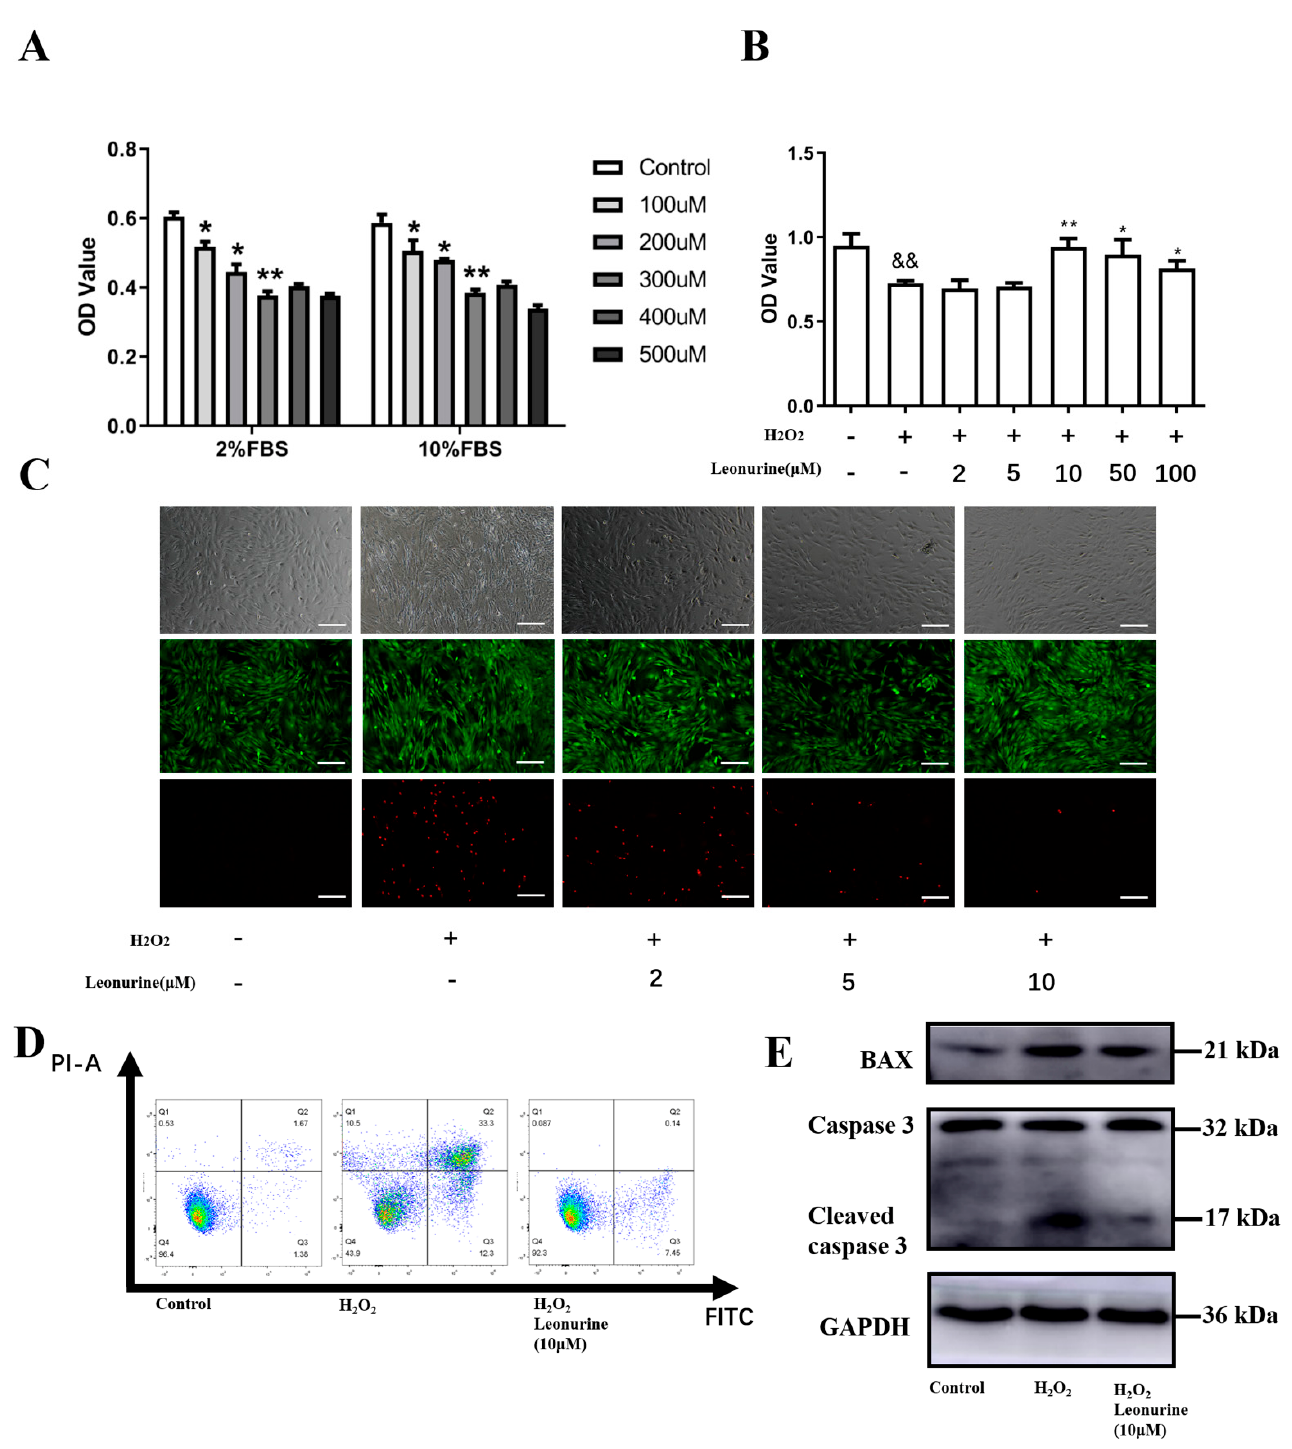
Figure 1. ( A ) CCK-8 essay for BMSCs co-cultured with different concentrations of H 2 O 2 . ( B ) Evalua- tion of leonurine protection at different concentrations in skeptical ROS burden. ( C ) Double live/dead staining (scale bar = 200 µ M). ( D ) Distribution of apoptotic BMSCs observed under flow cytometry (FITC-Annexin V apoptotic detection assay). ( E ) Expression of apoptosis-related protein